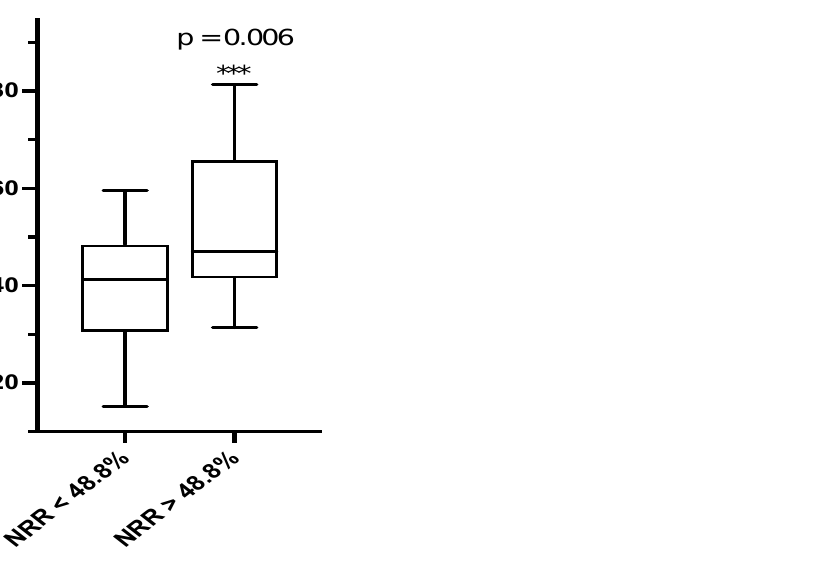
Figure 4. Box representation of the proAKAP4 average concentrations in post-thawed straws that gave a NRR % at 90 days over or below the threshold of 48.8%. NRR: non-return rate at 90 days post insemination and proAKAP4 concentration as a ng per 10 million of spermatozoa (ng/10 M spz). n = 199,100 artificial inseminations. *** means significant differences ( p = 0,006)